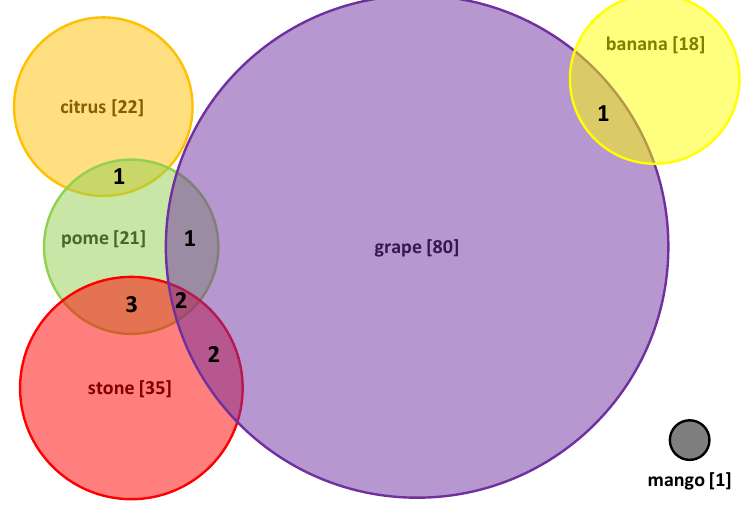
Figure 1. Venn diagram illustrating virus cross-infections among woody fruit